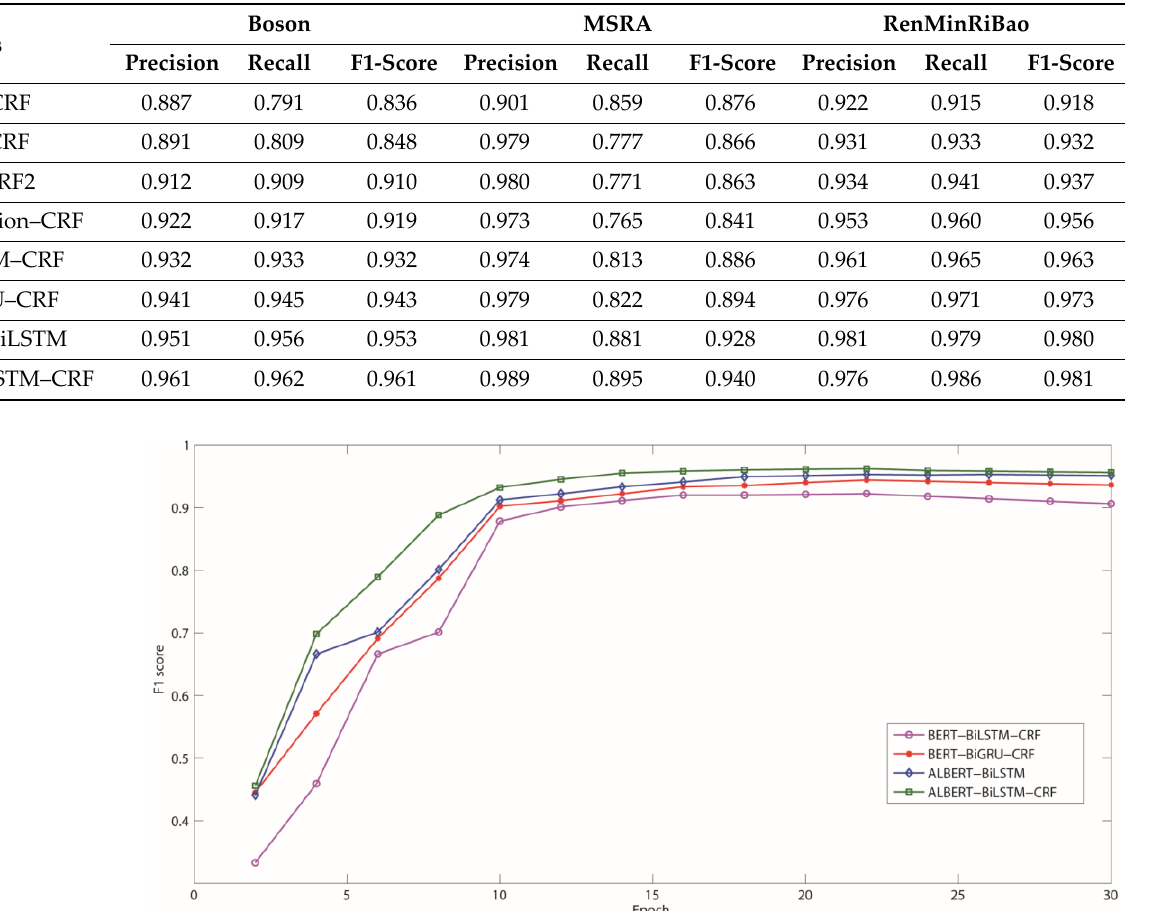
Table 11. Results of models on the Boson, MSRA, and RenMinRiBao datasets.